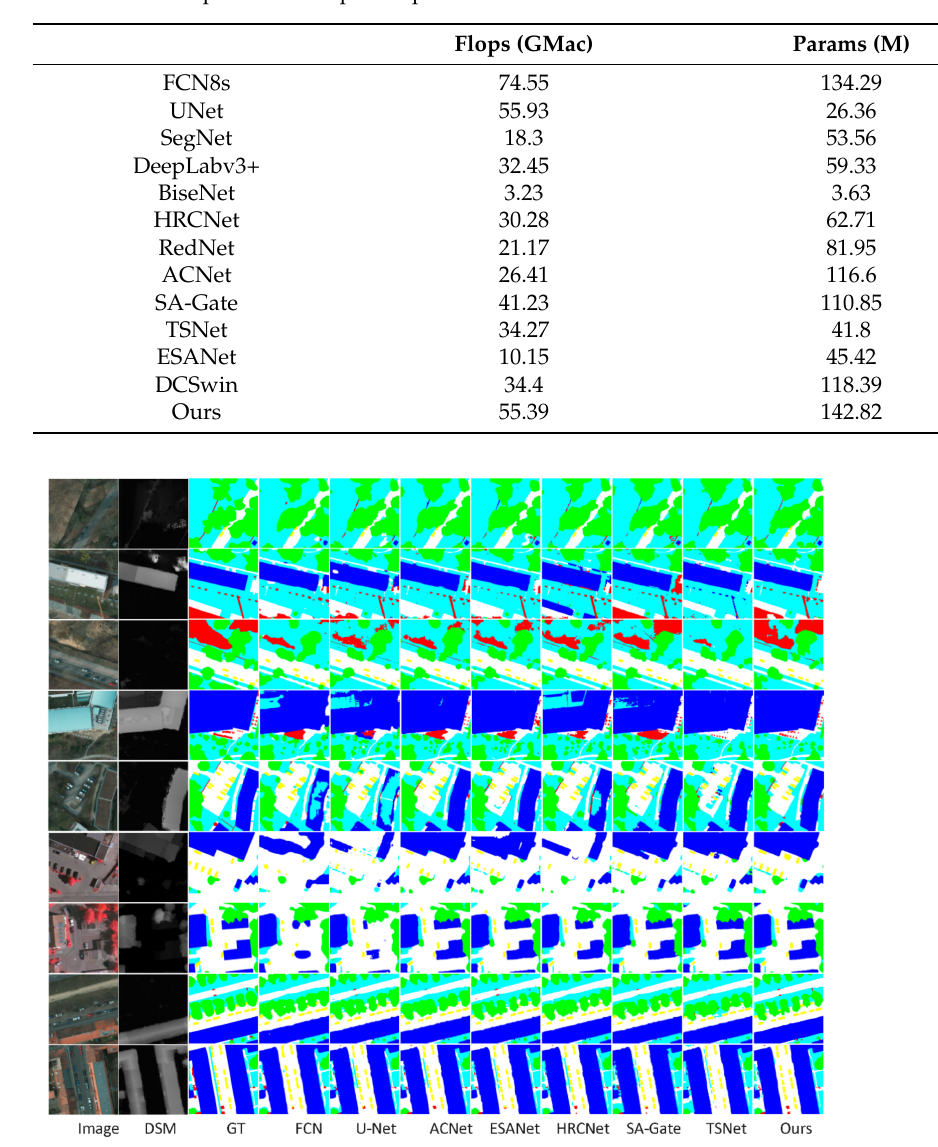
Figure 3. Comparison of segmentation results from different